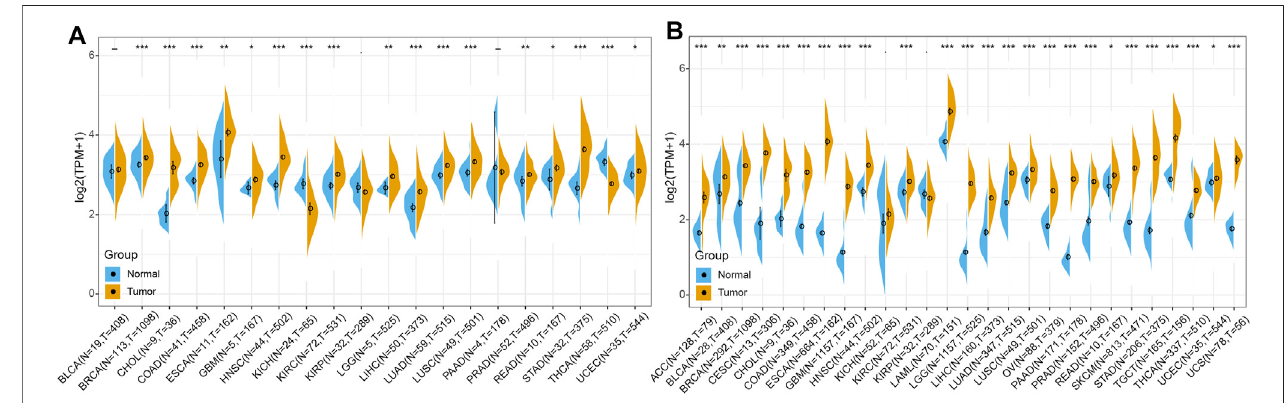
FIGURE 2 | RBM15 is aberrantly expressed in human pan-cancer. (A) Abnormal expression of RBM15 in tumor and normal tissues from TCGA database. (B) RBM15 is aberrantly overexpressed in 25 tumor types from TCGA and GTEx database. * p < 0.05, ** p < 0.01, *** p <